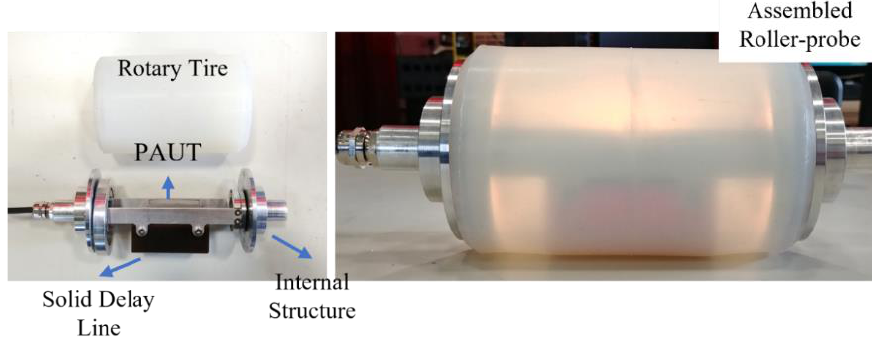
Figure 2. The internal structure of the roller-probe ( left ) and assembled device ( right ).